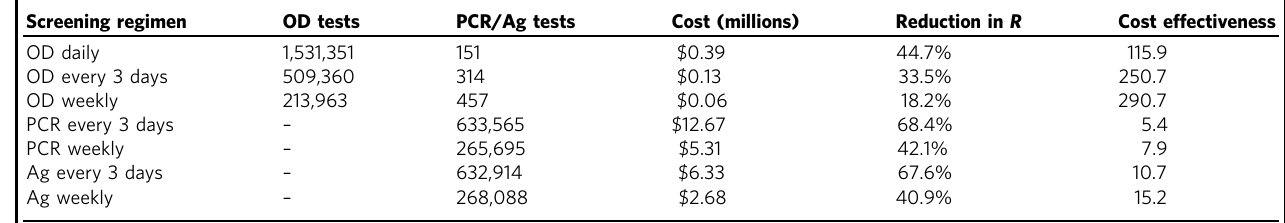
Table 1 Cost effectiveness of repeated screening programs. Screening